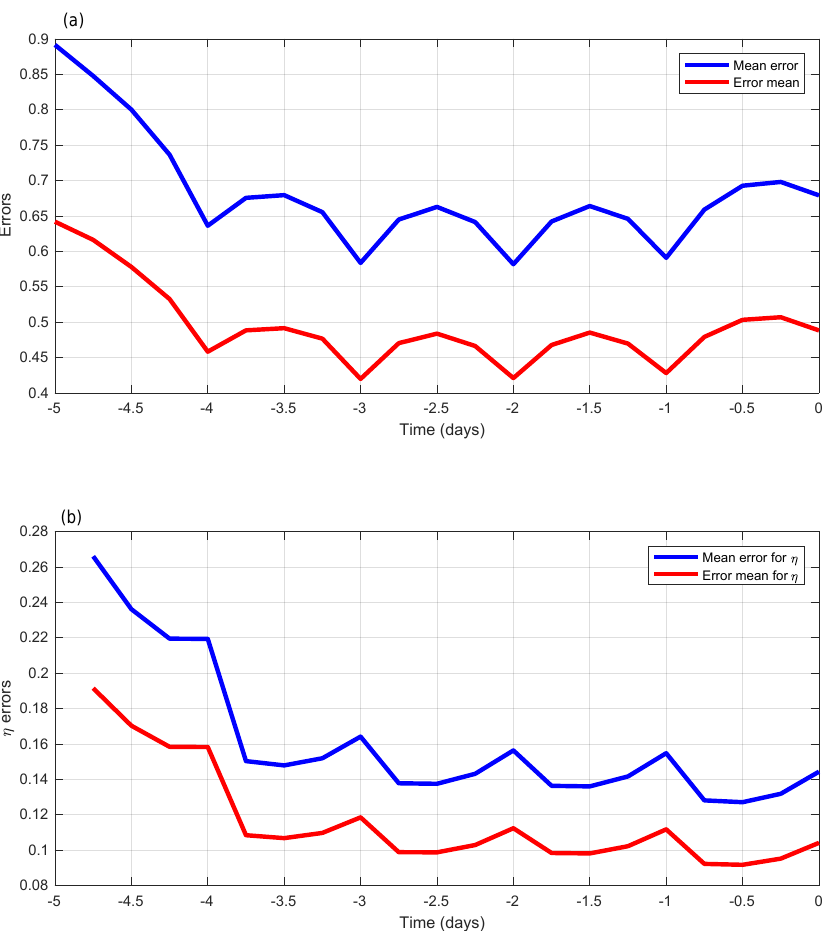
Figure 10. RMS estimation errors on the state variable x k and on the model noise b k ( a and b respectively) for weak-constraint variational assimilations performed over 5-day windows, with observations at times − 5 , − 4 ,...,